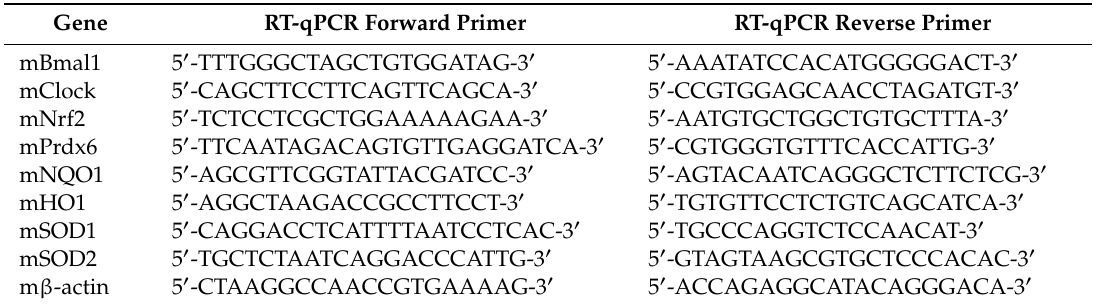
Table 2. Primers and sequences (5 (cid:48) to 3 (cid:48) ) used for the mRNA analysis.